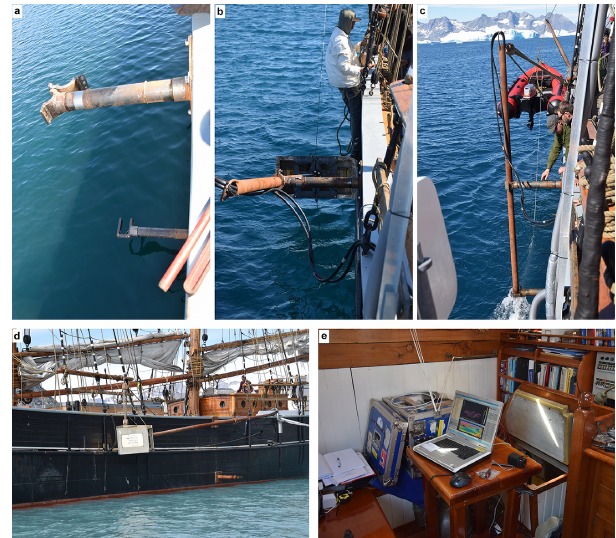
Figure 3. Deployment of the multibeam system onboard SS ACTIV using a clamp and a U-shaped clip (a-b) . (c) The system during the surveying mode and (d) the system in the safe position used for transit. The multibeam system and computers were in installed in the wheelhouse (e)